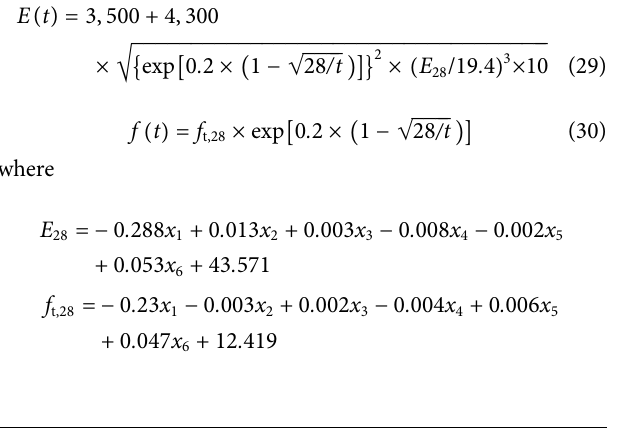
TABLE 7 | Range of independent variables.